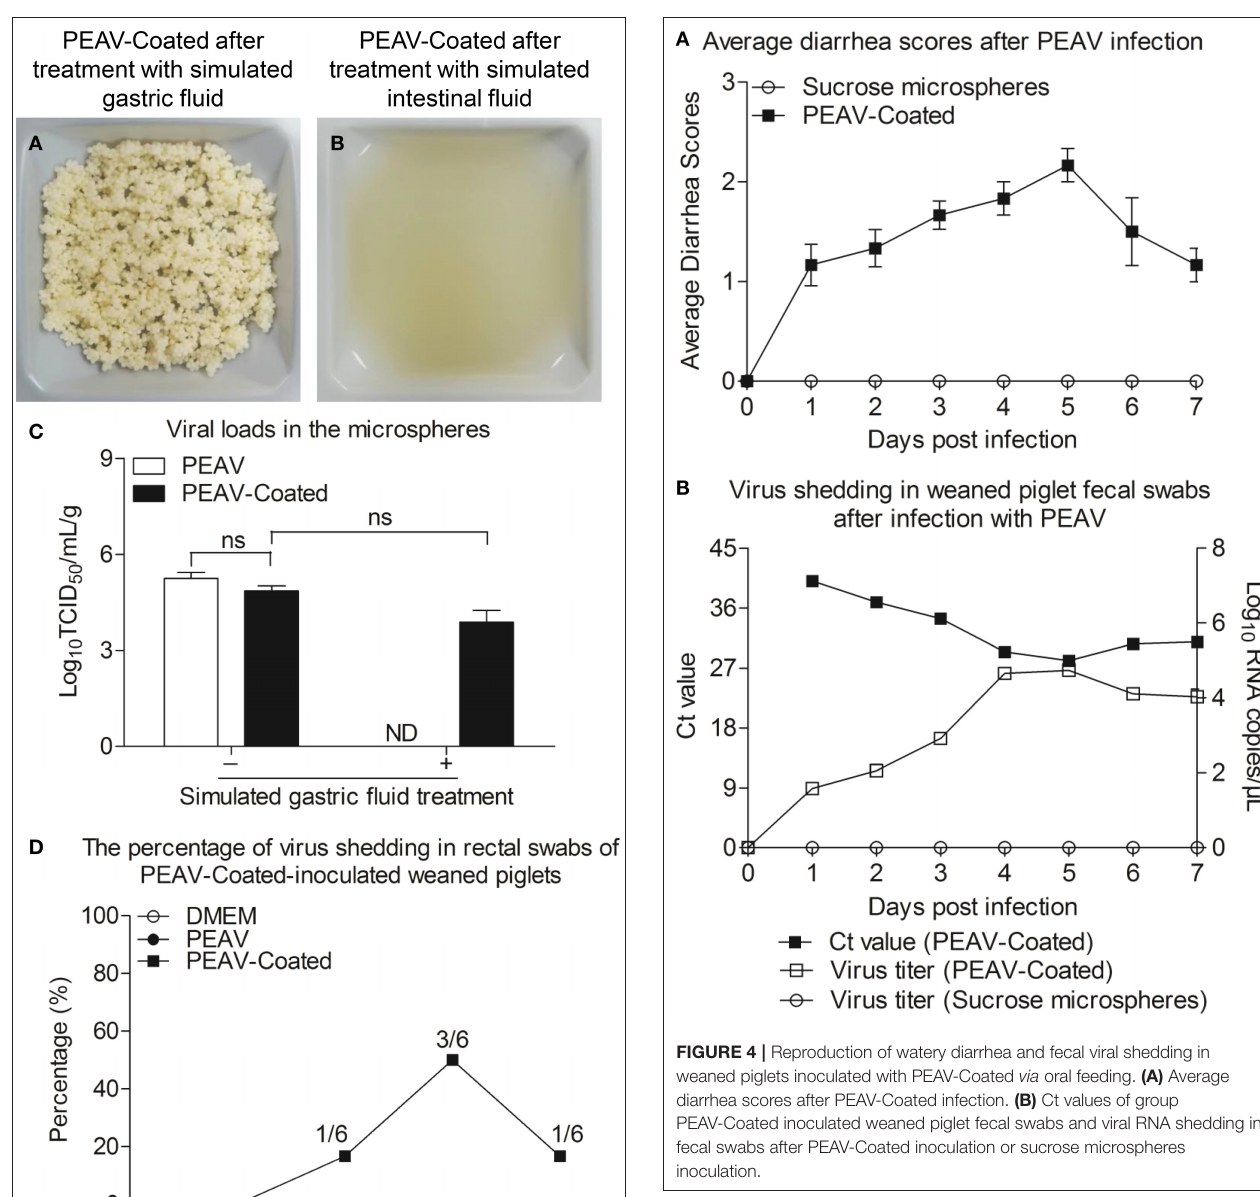
PEAV-Coated Inhibits an